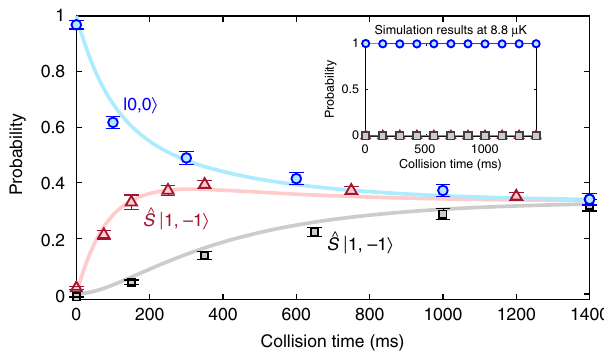
Fig. 3 Effect of bias magnetic fi eld. The left axis represents the |0, 0 〉 population at 40 ms of collision time relative to the |0, 0 〉 population at t = 0. Both the experimental (blue circles) and simulation (red squares) results are plotted as a function of the magnetic fi eld. Error bars in the experimental data denote the standard error of the mean. Although the |0, 0 〉 population of the simulation at t = 0 is set to 1, in the experiment the population dynamics during the magnetic- fi eld ramp leave a |0, 0 〉 population of about 0.64 at t = 0. The right axis is the actual scale of the experimentally measured |0, 0 〉 population. The inset schematically shows the energy-level picture of the system. Atomic pairs in a given spin mode have accessible energies ε n ¼ (cid:2) h ω x ð n x þ 1 constrained by ð(cid:2) 1 Þ n x þ n y þ n z ¼ 1. A magnetic fi eld of strength B shifts the energy levels of modes ^ S j 1 ; (cid:2) 1 i and ^ S j 2 ; (cid:2) 2 i by q 1 B 2 and q 2 B 2 , respectively, due to the quadratic Zeeman effect. Spin-changing collisions couple these energy levels, with coupling strengths g m details. Source data are provided as a Source Data fi le were relative-motion eigenstates of ^ p 2 = ð 2 μ Þ þ